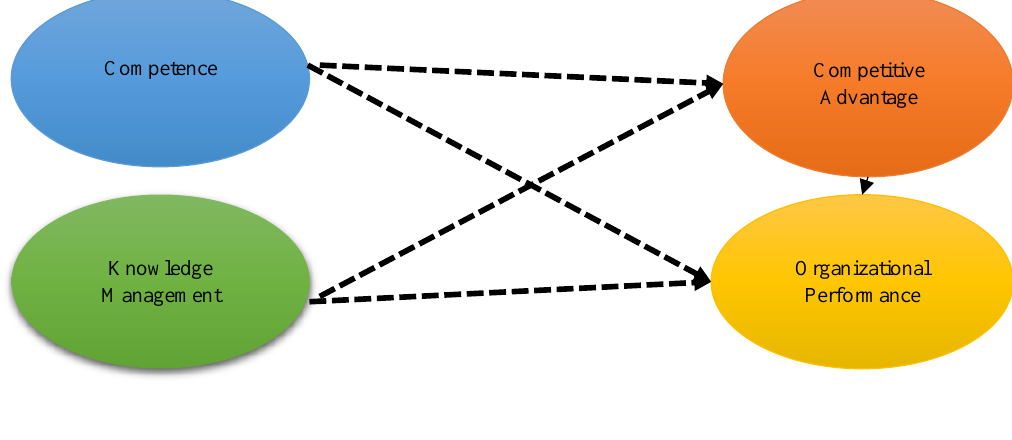
Figure 1. Research Framework,